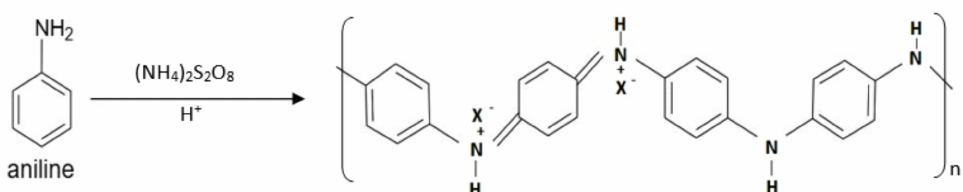
Figure 6. Chemical synthesis of aniline with ammonium persulfate in HCl acidic medium to form PANI (ES) (X − = Cl −